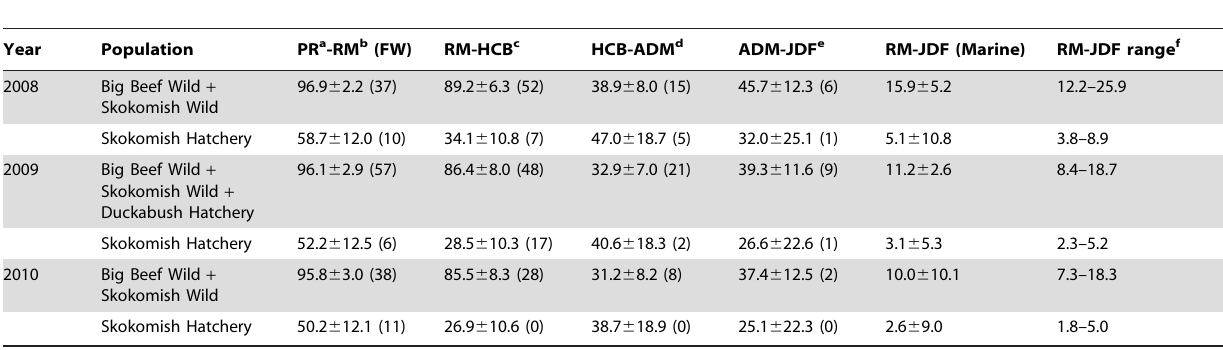
This model grouped wild Big Beef Creek and Skokomish River smolts as having different survival probabilities than Skokomish Hatchery smolts. Numbers of fish detected at the end of each segment are reported in parentheses. a PR=Point of Release. b RM=River Mouth. c HCB=Hood Canal Bridge Line. d ADM=Admiralty Inlet